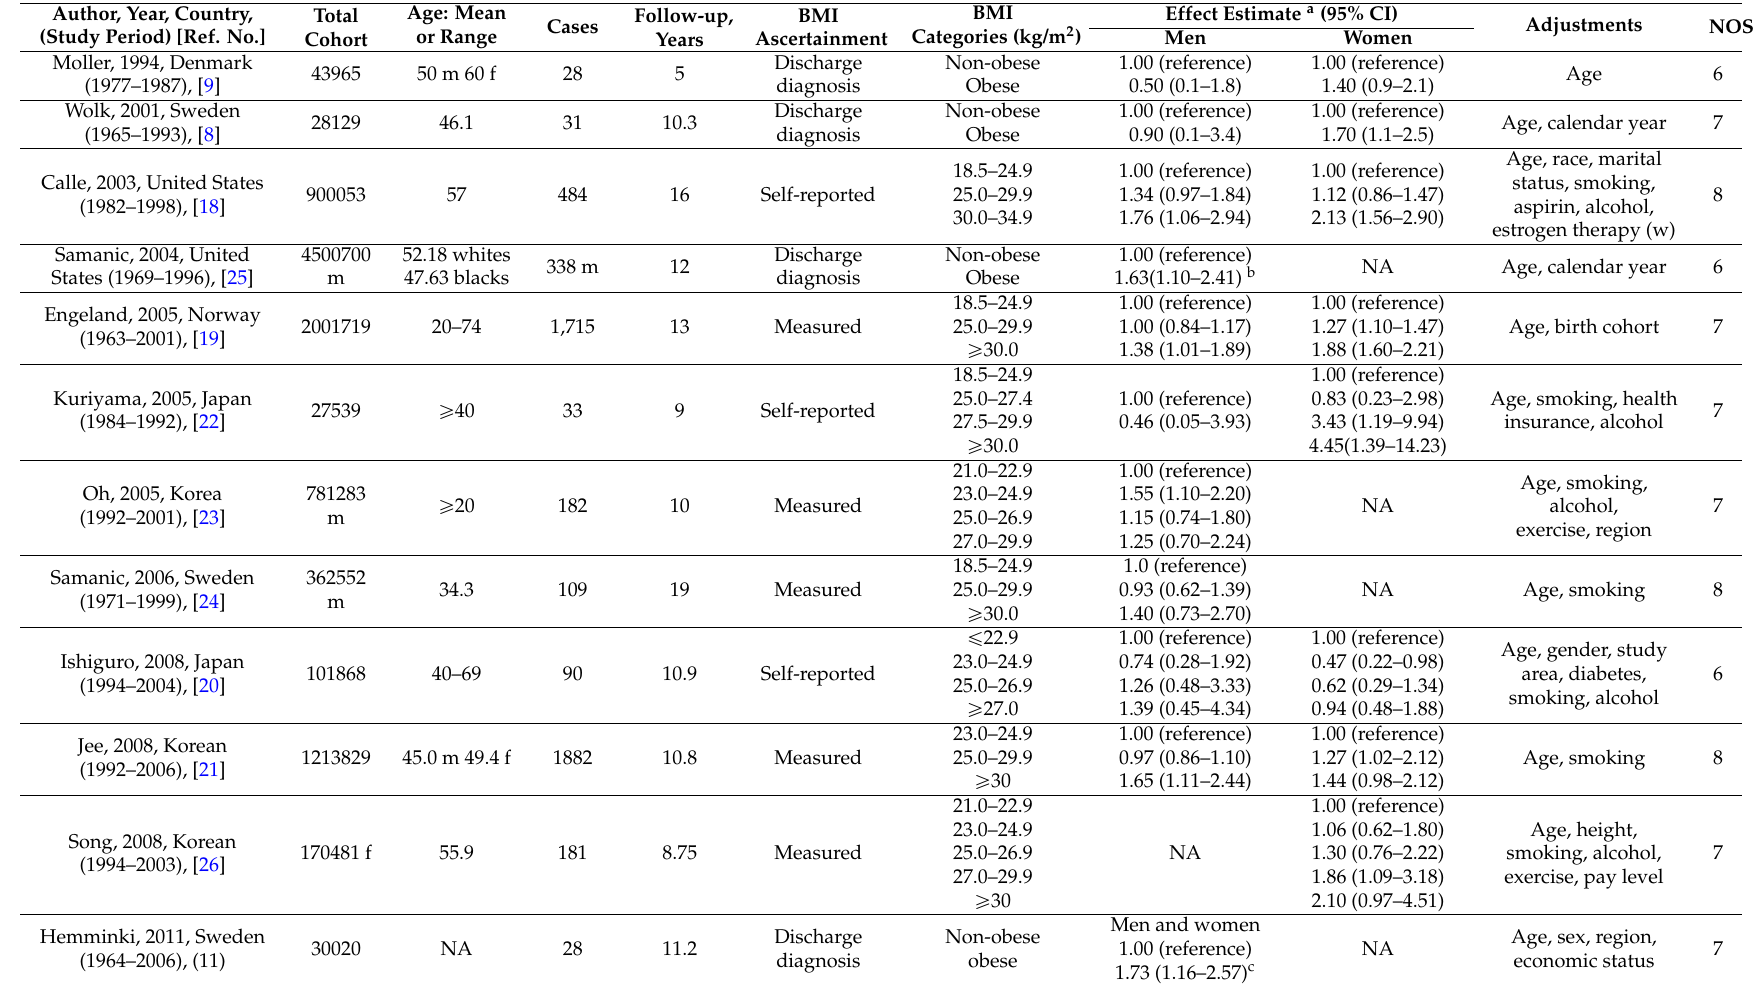
Table 2. Characteristics of 12 cohort